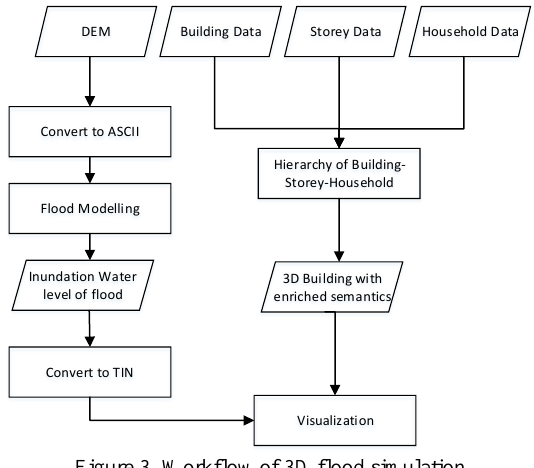
Figure 3. Workflow of 3D flood simulation